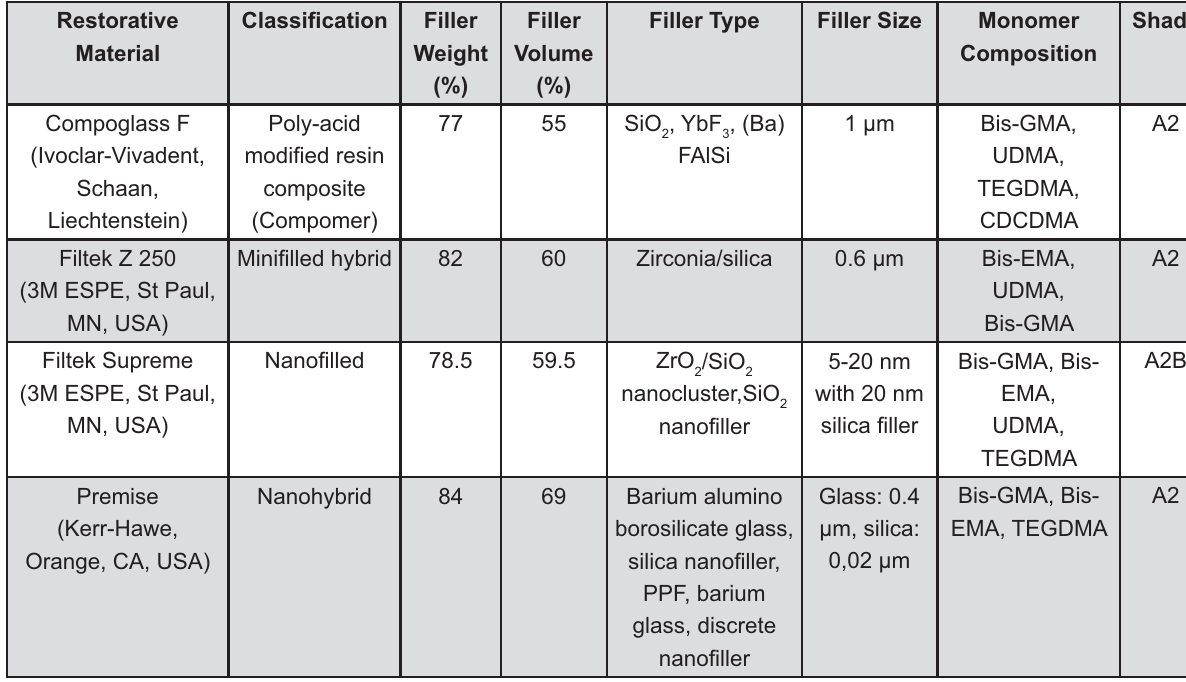
Figure 1- Composition of the restorative materials used in the